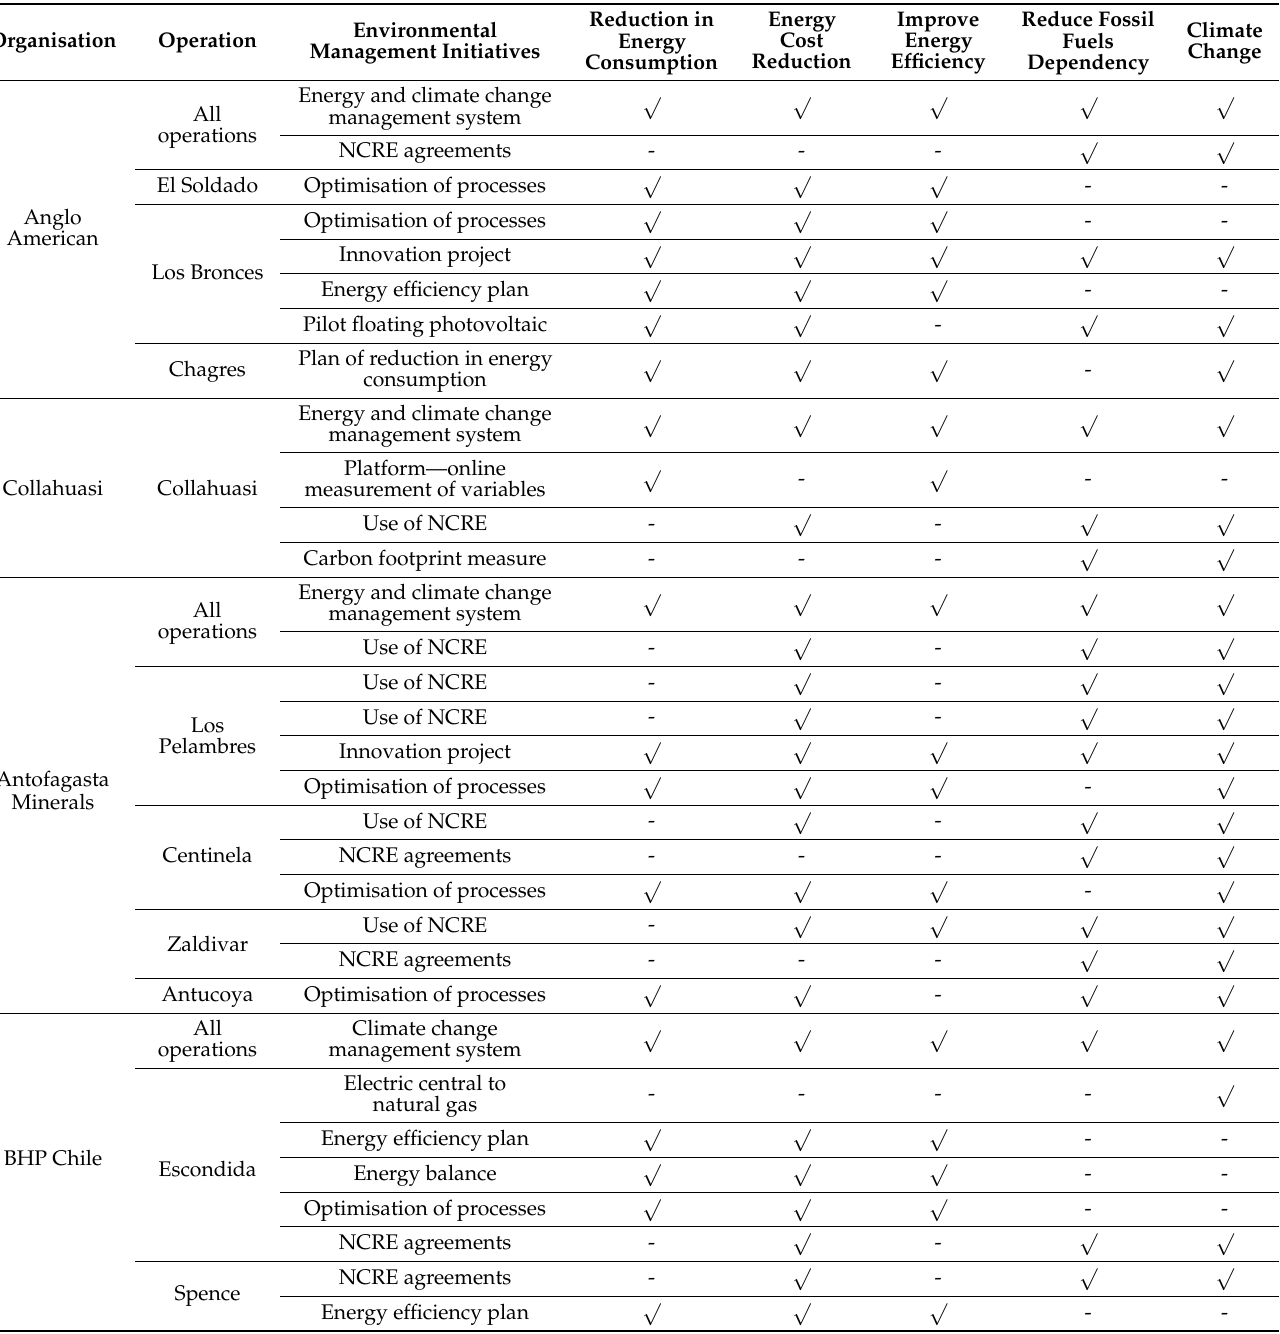
Table 4. Relevant EMIs to deal with energy